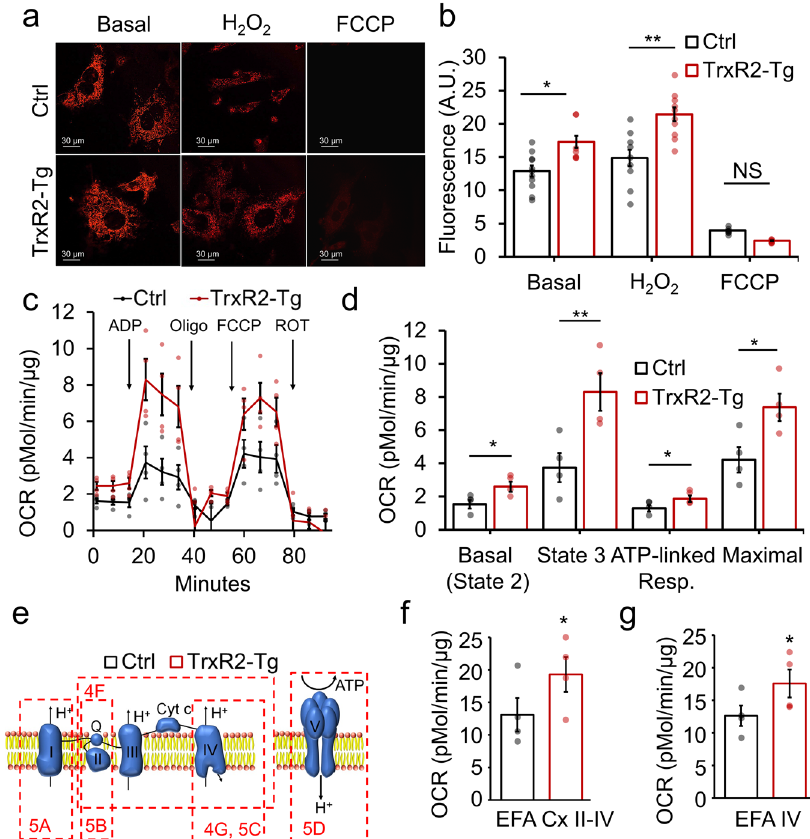
Fig. 4 TrxR2-Tg MEFs display elevated mitochondrial membrane potential and electron transport chain function. a TrxR2-Tg MEFs live-cell confocal imaging with 10 nm TMRM. b TMRM fl uorescence intensity was analyzed with ImageJ and TrxR2-Tg MEFs display higher mitochondrial membrane potential than non-transgenic controls ( n = 3 with triplicates). c Coupling seahorse assay showing oxygen consumption rate (OCR) trace with injection sequence of mitochondria isolated from livers of TrxR2-TG mice and littermate controls ( n = 4). d All calculated respiratory parameters are increased in TrxR2-Tg mitochondria relative to non-transgenic controls ( n = 4 mice with 10 technical replicates). e Schematics of the ETC are used to depict the sequence of complexes measured for each fi gure panel. f Seahorse electron fl ow assay (EFA) assessing respiratory fl ow from complex II to complex IV ( n = 4). g Seahorse electron fl ow assay (EFA) assessing Complex IV respiration. Values are Mean ± SEM. * p <